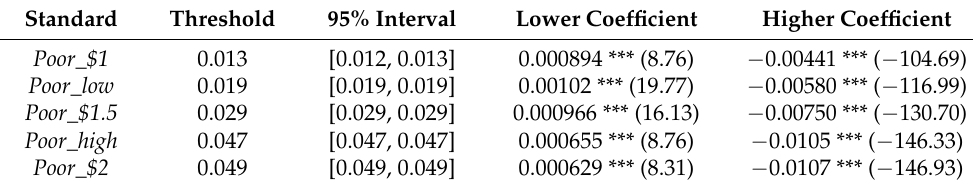
Table 24. Threshold estimates, confidence intervals, and coefficient changes.